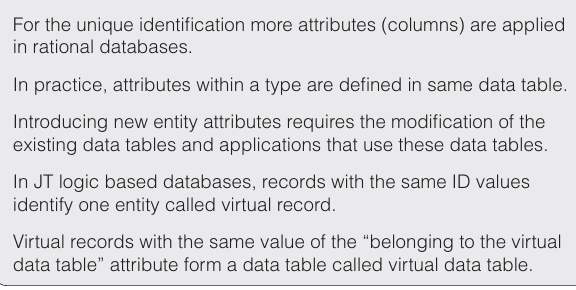
Figshare: Data storage structure in JT logic based databases. doi:10.6084/ m9.figshare.3119086.v1